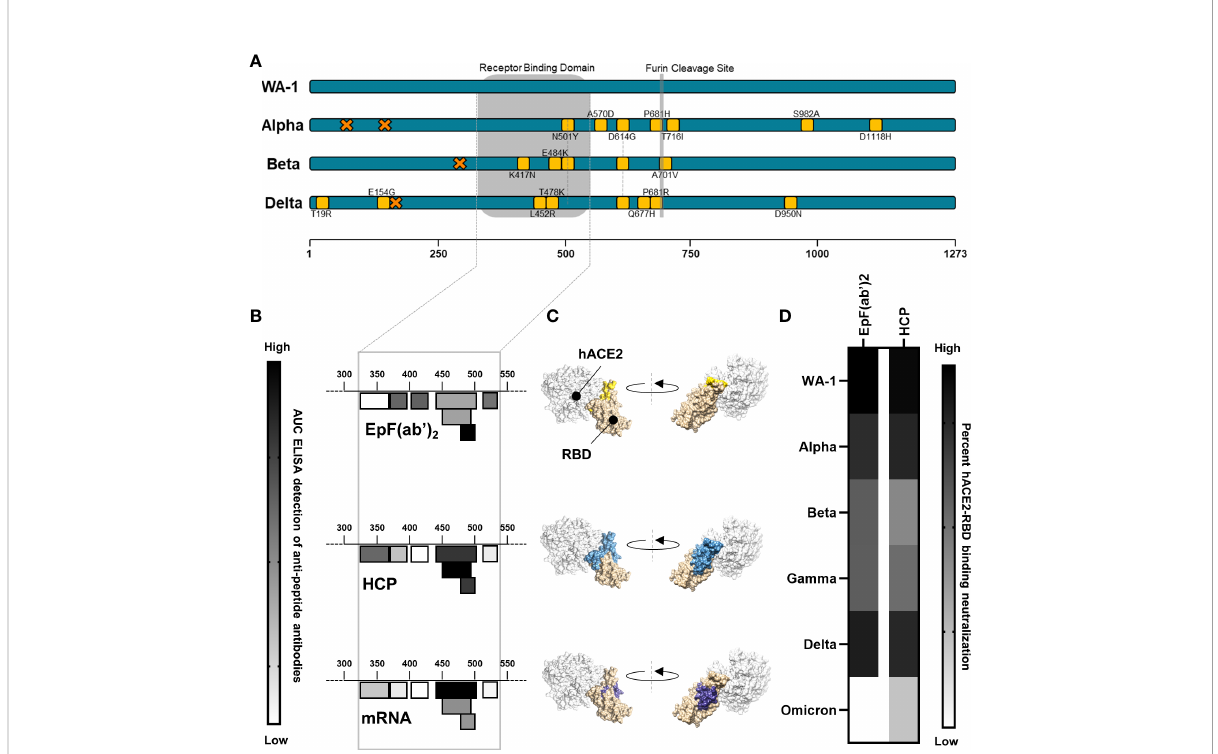
FIGURE 1 EpF(ab ’ ) 2 binds to RBD and neutralize RBD-hACE2 interaction. (A) Graphical representation of the mutations on each of the viral strains used in this study. Amino-acid deletions are depicted with orange crosses and point mutations with yellow squares. (B) Heat map of the ACU from ELISA detection of the binding of EpF(ab ’ ) 2 , HCP, and mRNA sera to seven peptides in the RBD region of the SARS-CoV-2 spike protein. Darker colors represent higher binding to the peptides. (C) 3D representation of the SARS-CoV-2 RBD binding to the hACE2 protein. Areas of highest binding as determined in B are highlighted in colors for EpF(ab ’ ) 2 (yellow), HCP (blue), and mRNA (purple). (D) Heat map representing percent inhibition of RBD binding to hACE2 determined using neutralization assays at non-saturating concentrations of antibody for EpF(ab ’ ) 2 and HCP. Darker colors represent higher binding